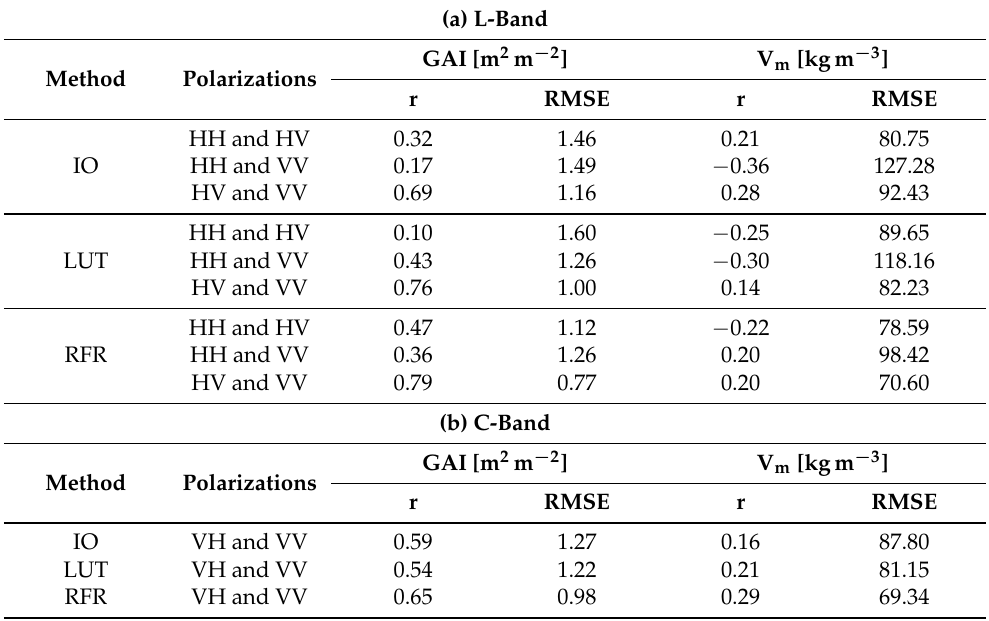
Table 5. Results from the LOOCV for the simultaneous retrieval of GAI and volumetric surface soil moisture, V m , in maize fields from ( a ) L- and ( b ) C-band backscattering measurements ( n = 26) with different inversion strategies for the WCM: the iterative optimization method (IO), the look-up table search (LUT), and the random forest regressor